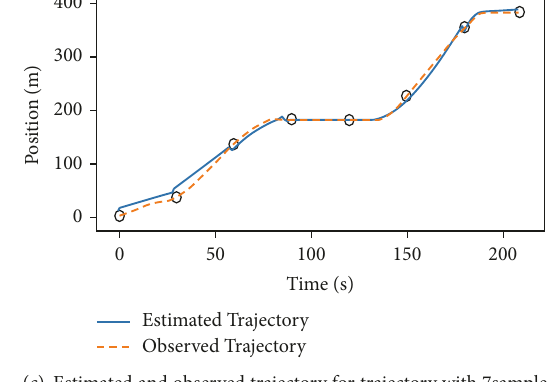
Figure 8: Estimated and observed trajectories for different types of